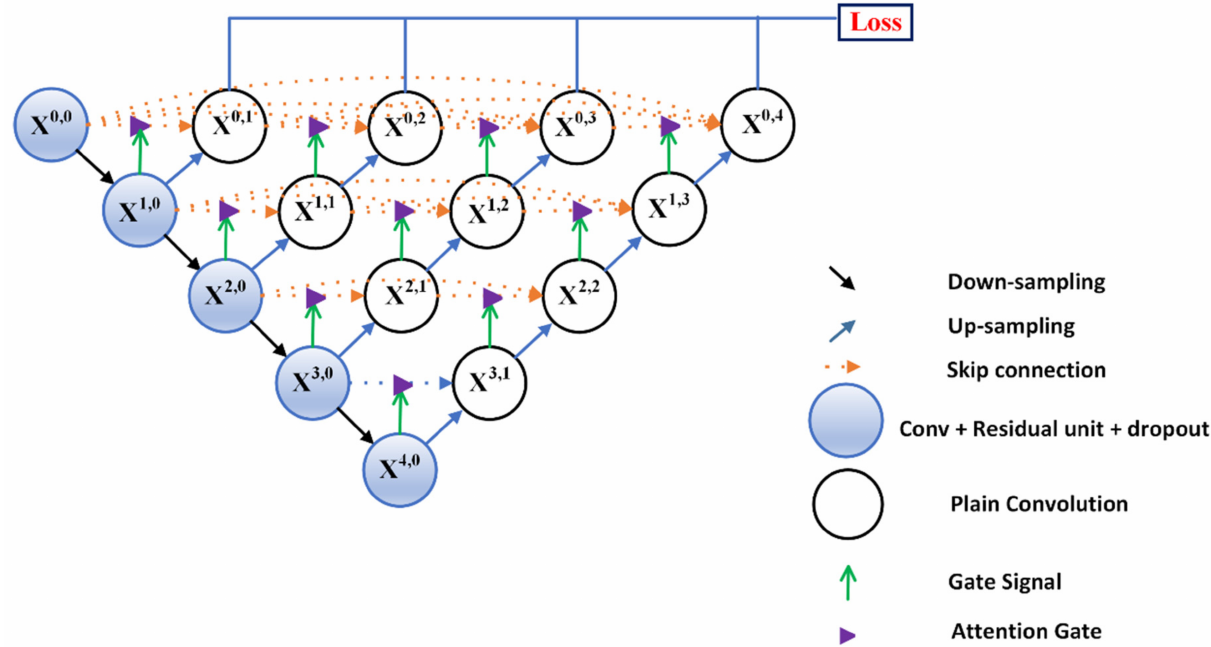
Figure 4. Architecture of Residual-Attention